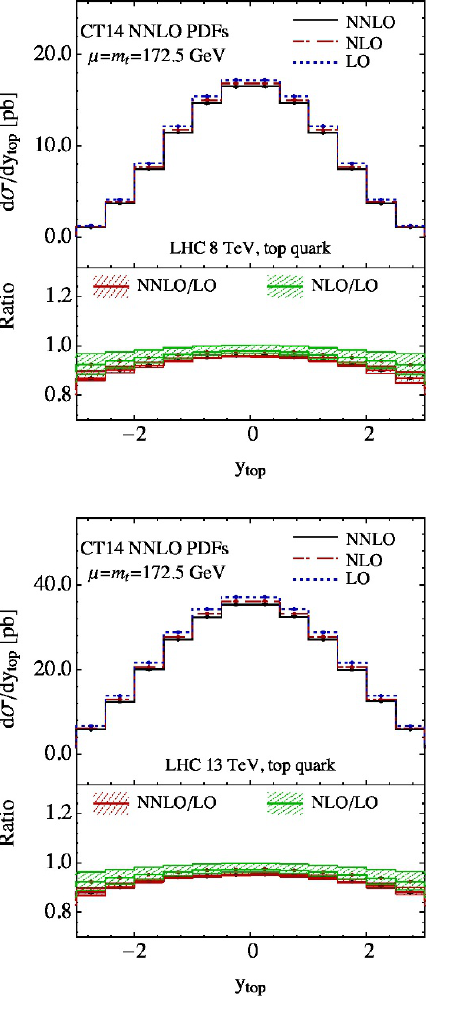
Figure 21 . Predicted rapidity distribution of the top (anti-)quark from t -channel single top-quark production at 8 and 13